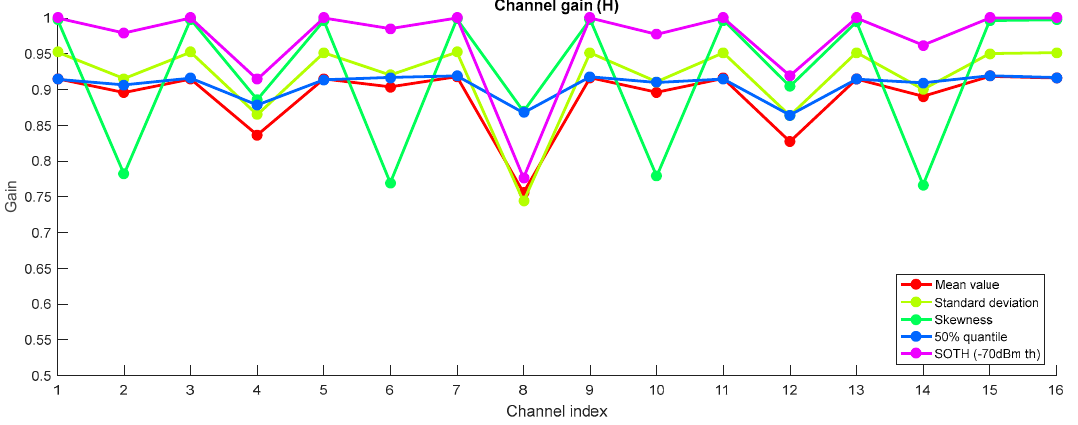
Figure 5. Normalized channel gains from RSSI statistical properties of Figure 4.